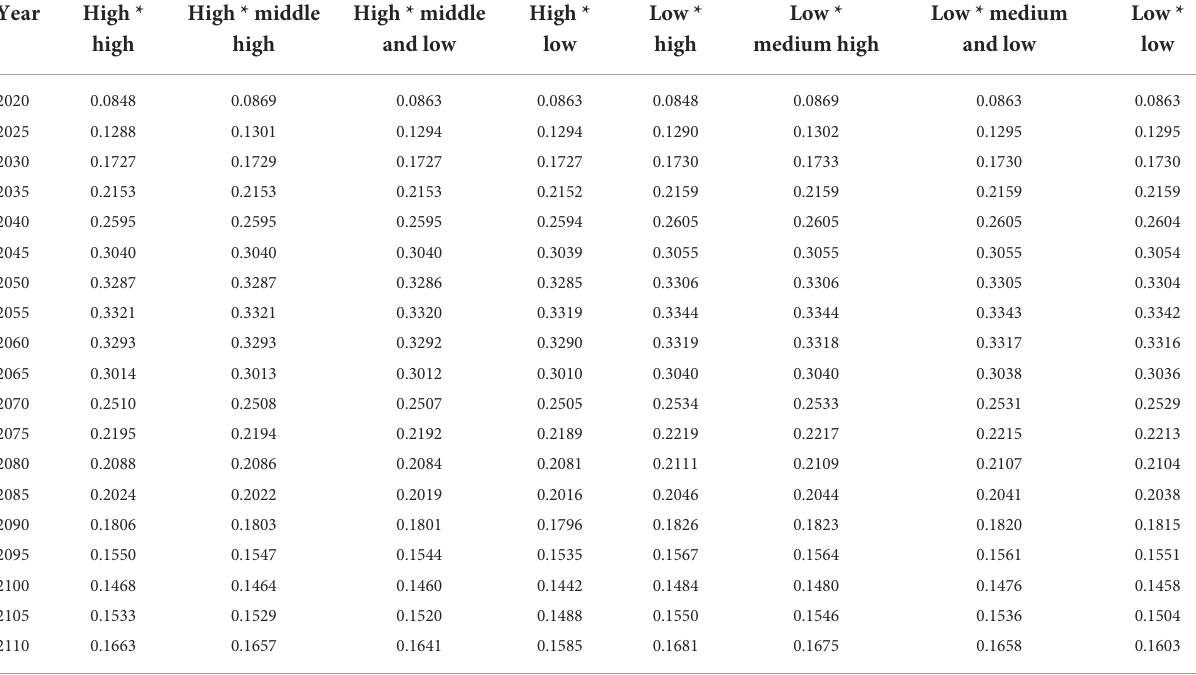
TABLE 1 Proportion of total LTCI expenditure in GDP in Nantong from 2020-2110 under different economy-population scenarios (%).